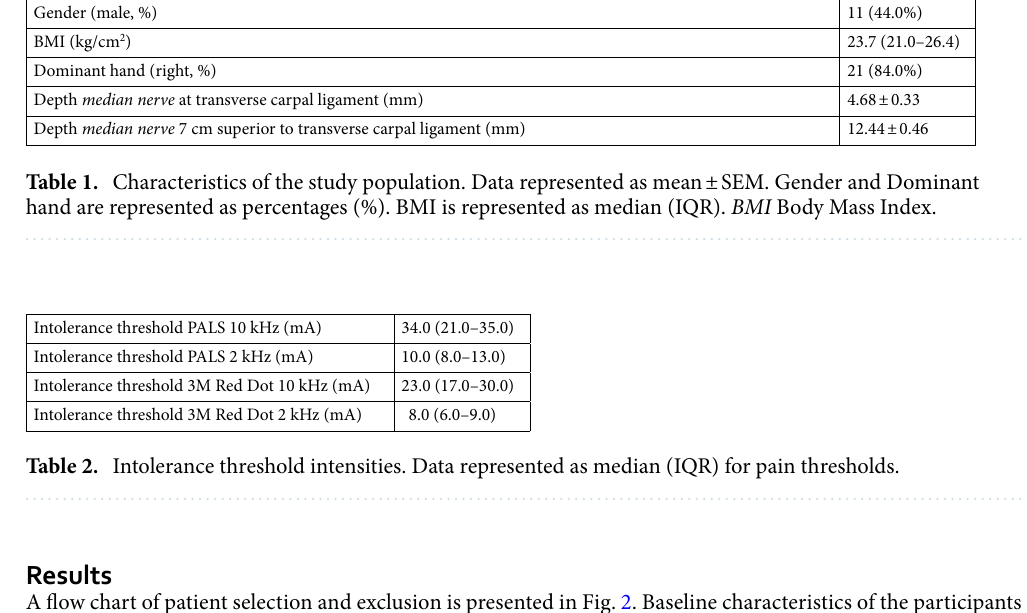
Table 2. Intolerance threshold intensities. Data represented as median (IQR) for pain thresholds.